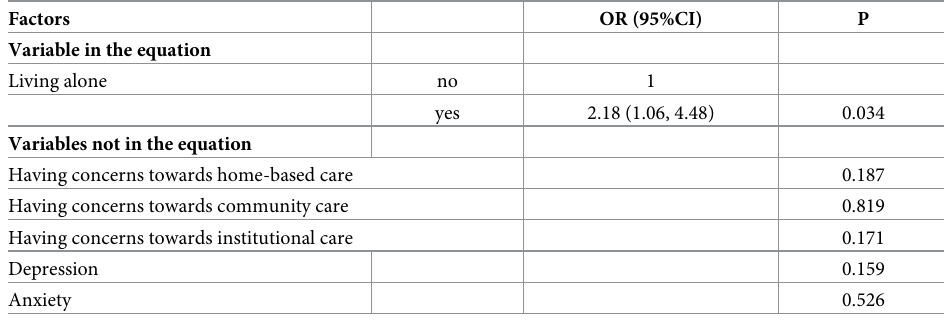
Table 6. Factors associated with willingness to receive community-based eldercare.